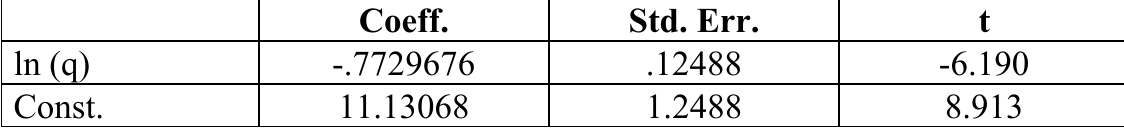
Results of estimating a constrained log-log demand function for tourists from African countries Coeff. Std. Err.